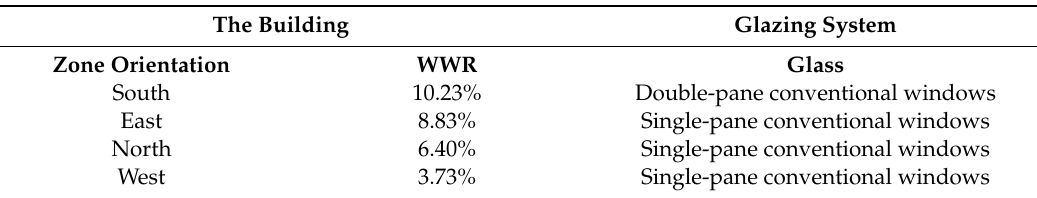
Table 2. Window-to-wall ratio.